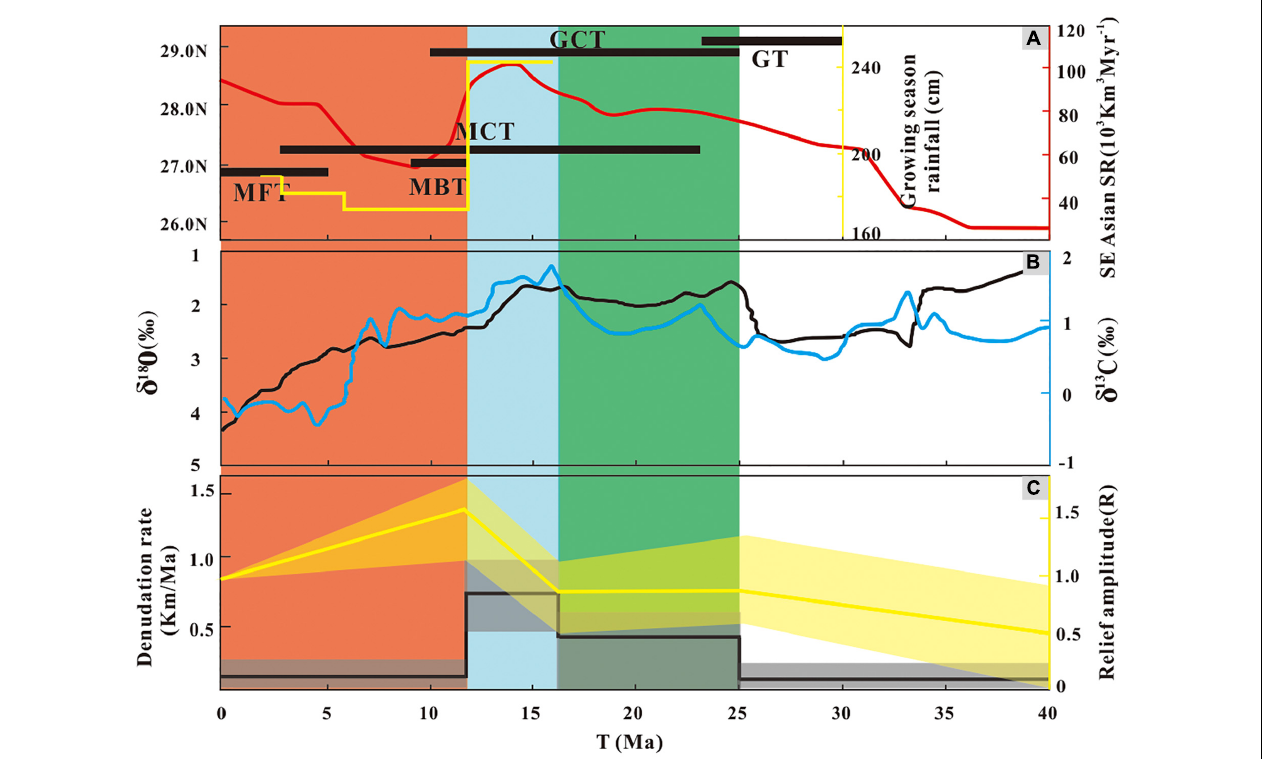
FIGURE 7 | A comparison of the geologic events in south Tibet and Himalaya, the Asian summer monsoon, and the denudation rate and relief history of the Lhasa River drainage since ∼ 40 Ma. (A) The black horizontal lines represent the main deformation events for tectonic units of southern Tibet and Himalaya (Li Y. L. et al., 2015). MCT, Main Central thrust; MBT, Main Boundary thrust; MFT, Main Frontal thrust. The yellow line represents that growing season precipitation modeled from CLAMP (Climate-Leaf Analysis Multivariate Program) for the eastern Himalayan Siwalik fossil leaf assemblages (Khan et al., 2019). The red line represents the Southeastern Asian offshore sedimentary accumulation rate (SR) (Clift, 2006). (B) The benthic oxygen and carbon isotope record is represented by black and blue lines, respectively (Zachos et al., 2001). (C) Continuous black and yellow lines represent the best-fit denudation rate and relief of the Lhasa River drainage, respectively. The shaded line represents 1 σ uncertainty on these